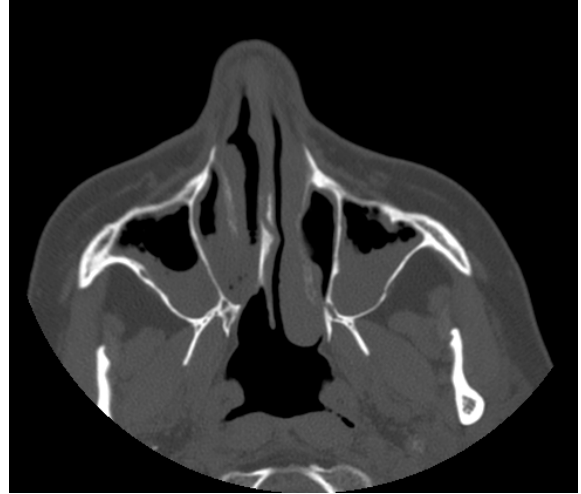
Figure 1. Axial scan of the facial massif where the polypoid formation is seen in both nostrils and maxillary sinuses.